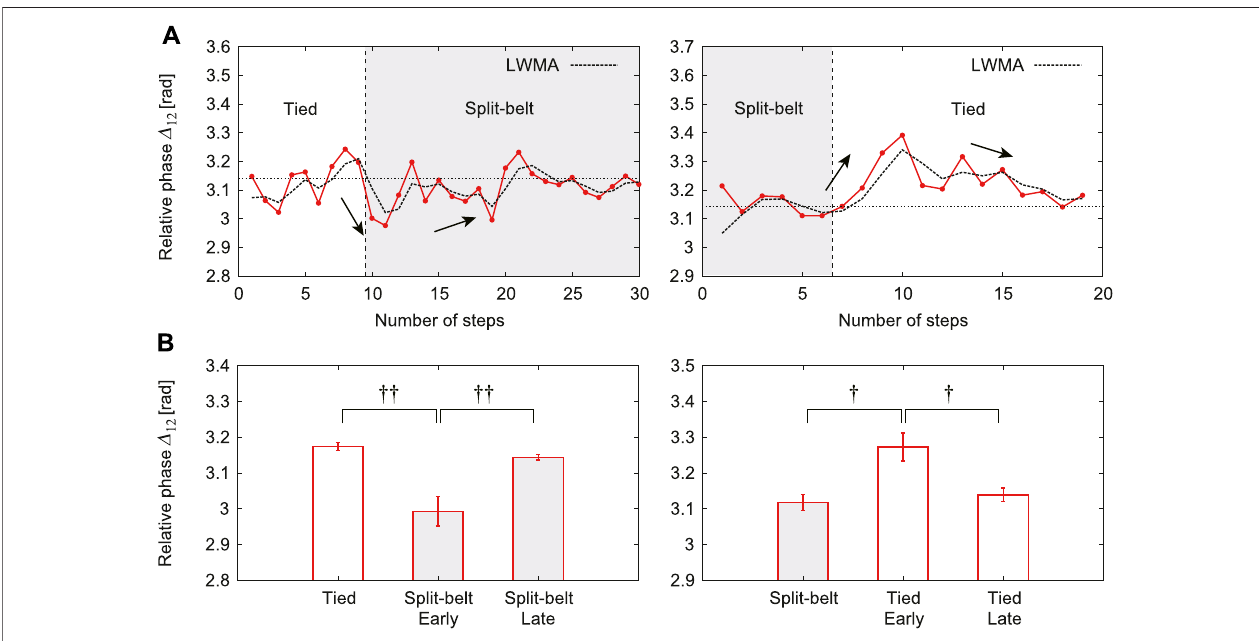
FIGURE 7 | Relative phase Δ 12 with use of both spinal and cerebellar models. (A) One representative trial with moving average [ fi ve-period linear weighted moving average (LWMA)]. (B) Average for each period. Data points and error bars are the mean and standard error results of fi ve experiments, respectively. † : p < 0 . 05 and †† : p < 0 .